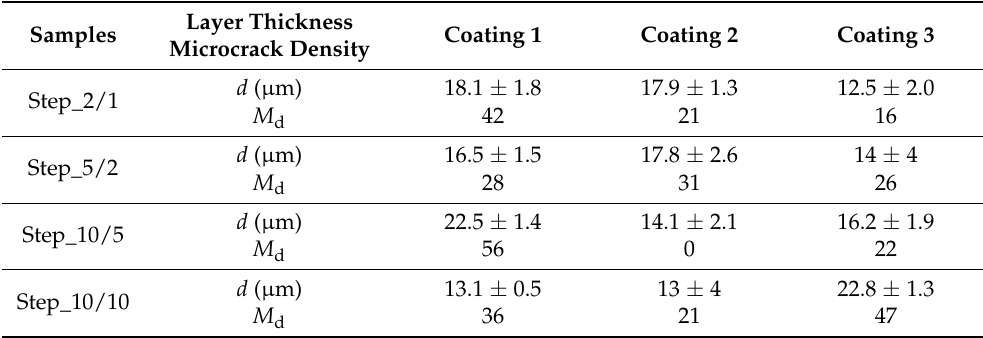
Table 4. Layer thicknesses d and microcrack density M d (number of cracks per 1000 µ m) of stepped DC coatings determined by optical